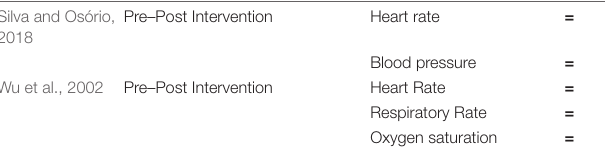
TABLE 5B | Effect of AAI on stress and pain (physiological outcomes) (uncontrolled